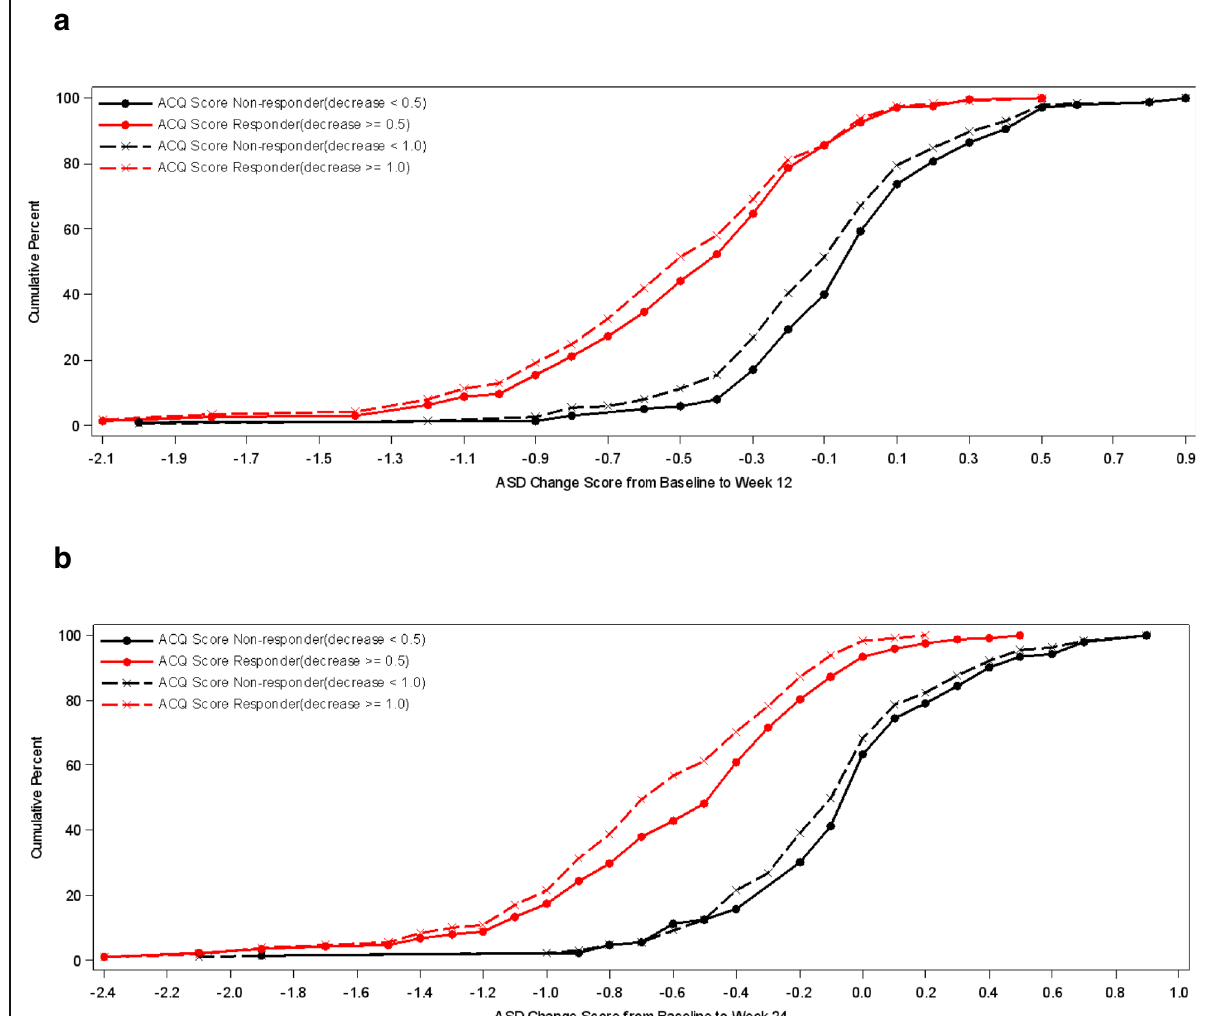
Fig. 1 Cumulative Distribution Curves for 7-Day Average ASD Scores by ACQ Based Responder Criteria. a Baseline to Week 12 by ACQ-5 Response. b Baseline to Week 24 by ACQ-5 Response. PRO analysis set includes all subjects who are enrolled and have Asthma Symptom Diary measurement at baseline and at 12weeks or